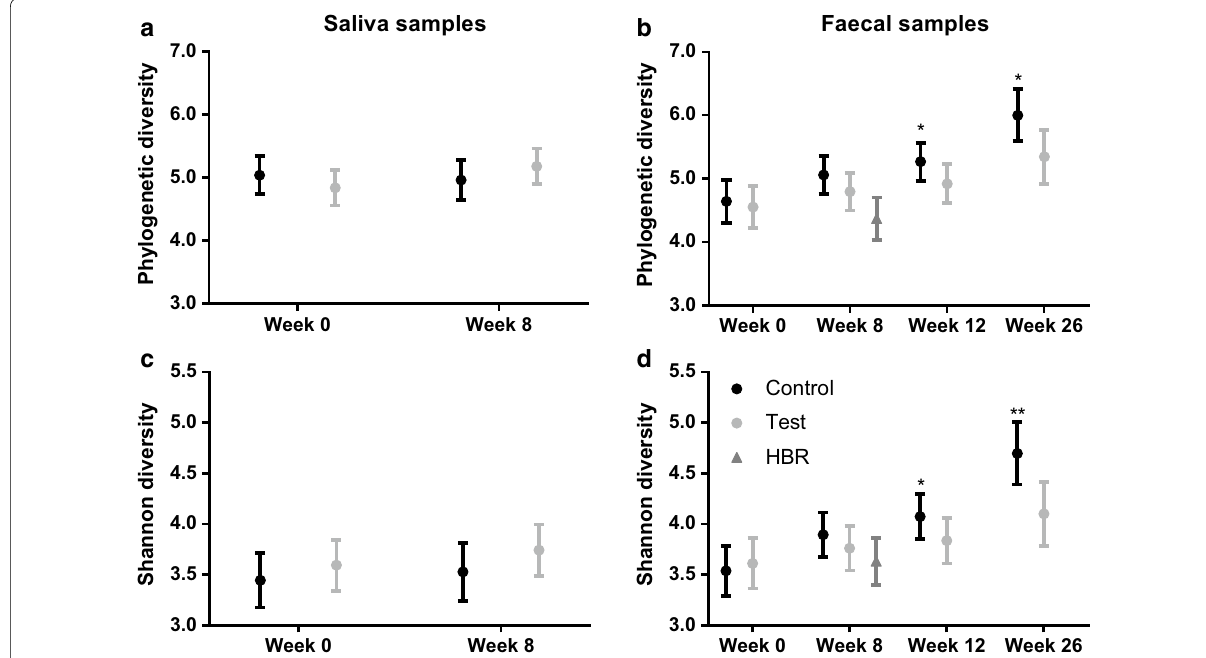
Fig. 2 Plots summarizing the bacterial diversity of saliva ( a , c ) and faecal samples ( b , d ) using Faith’s phylogenetic diversity and the Shannon index, respectively. The symbols and error bars show the least square (LS) means with 95% CI for treatment by time. The faecal bacterial diversity of the HBR reference group (age‑matched to week 8) is plotted as well. P‑values are based on a random intercept mixed model with week 8/12/26 values as outcome, stratification factor and baseline values as covariate and treatment as fixed effect: *P